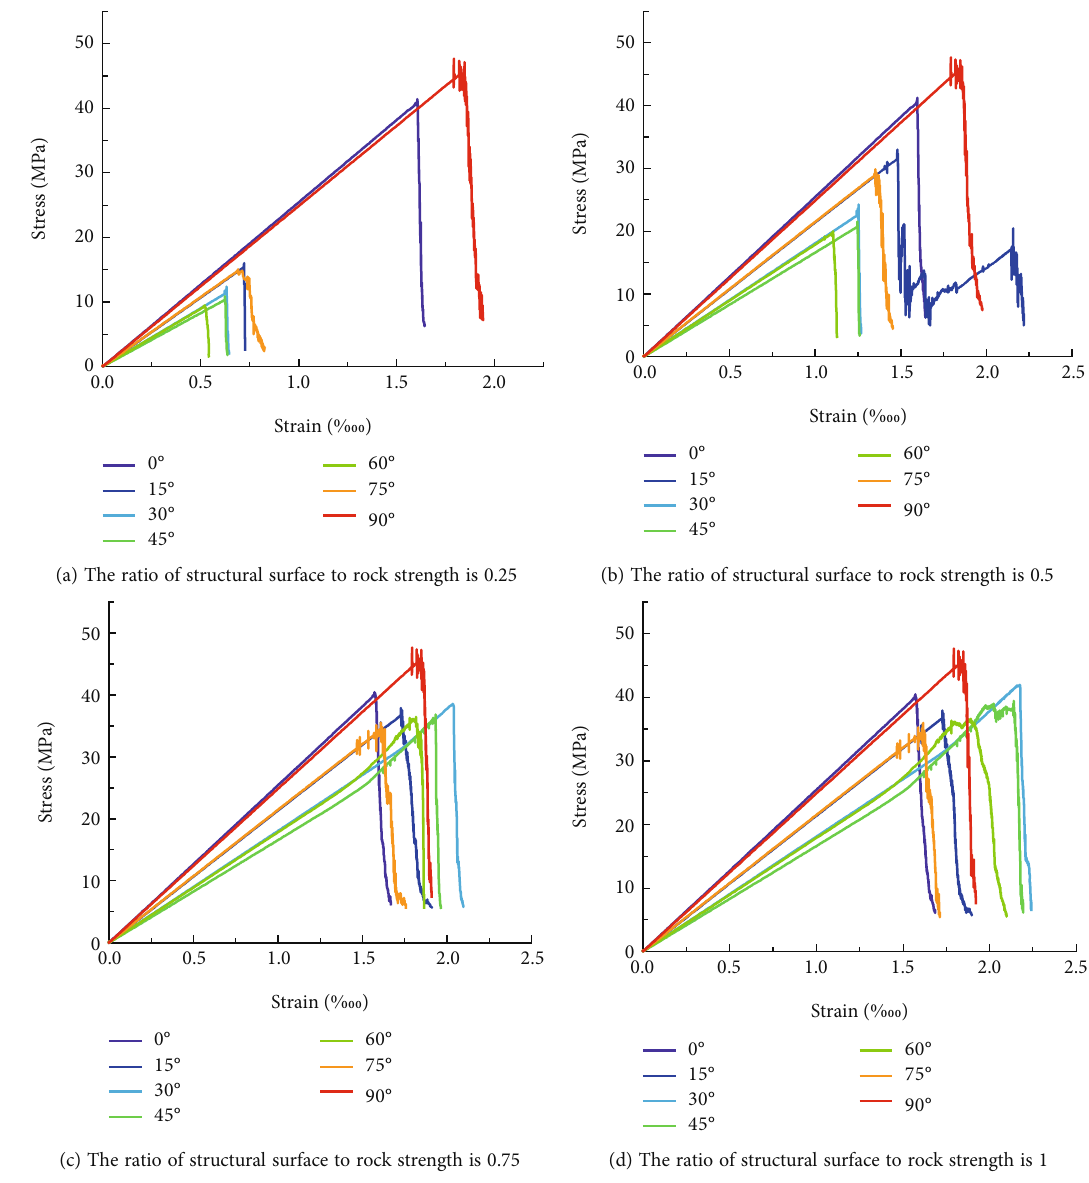
Figure 11: Stress-strain curves of rock mass with di ff erent strength ratios between structural surfaces and rock